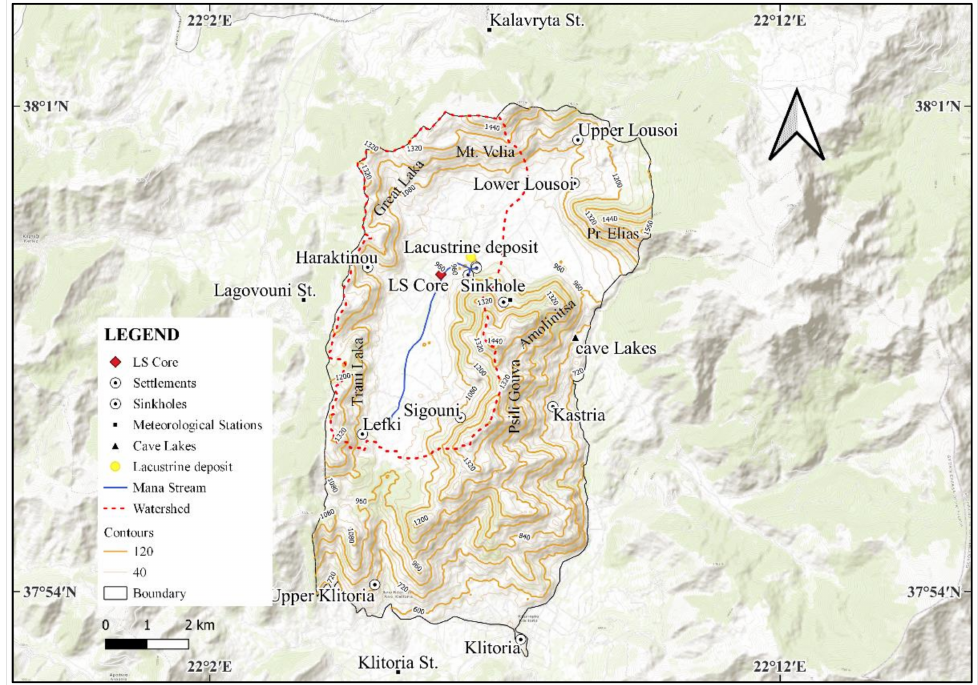
Figure 2. Geomorphological map of the study area presenting the main settlements and sinkholes, together with the core location, watershed, and drainage basin according to